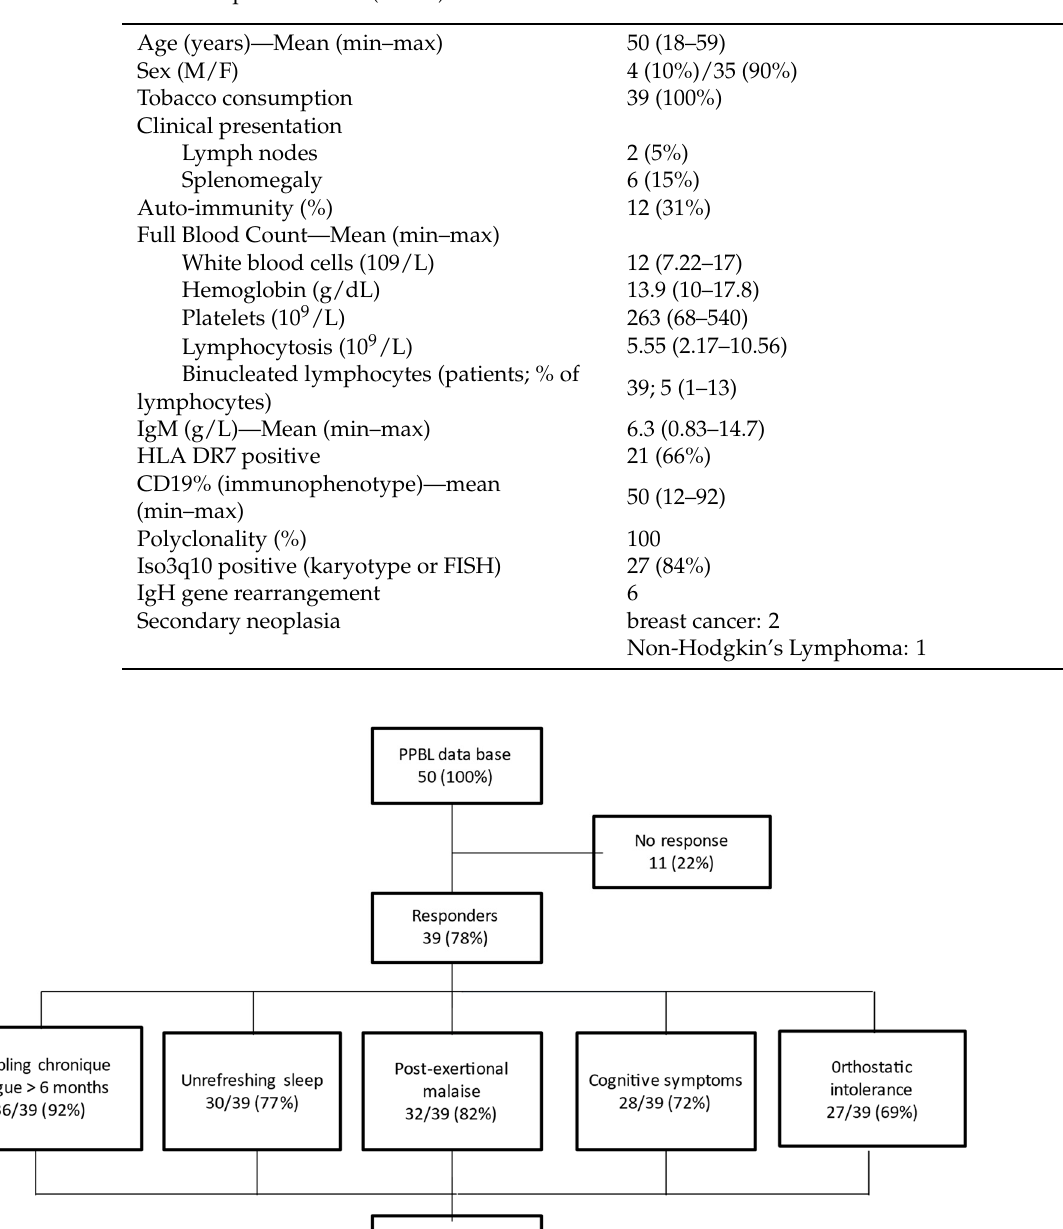
Table 1. Population data ( n = 39).